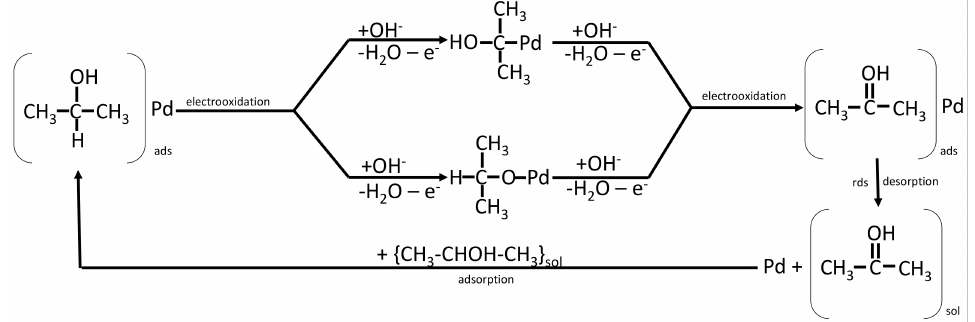
Figure 8. Reaction mechanism for isopropanol oxidation on Pd/Ni electrode reprinted with permis- sion of Elsevier